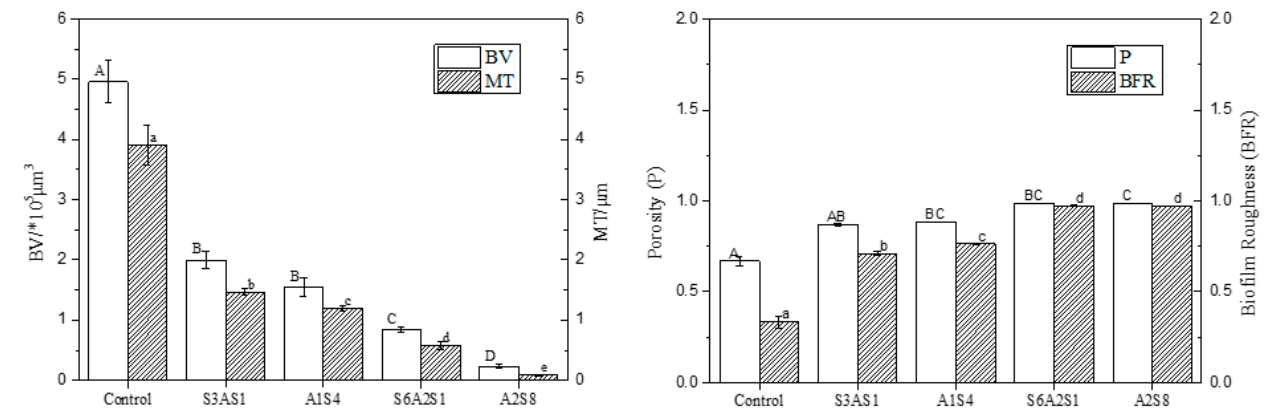
Figure 7. The CLSM images analysed by ISA-2 software to determine the biovolume (BV), mean thickness (MT), porosity (P) and biofilm roughness (BFR) of the biofilm. Data were expressed by mean measurements ± standard deviation (SD) and all treatments and determinations were performed in triplicate. The different letters indicate significant differences ( p < 0.05).